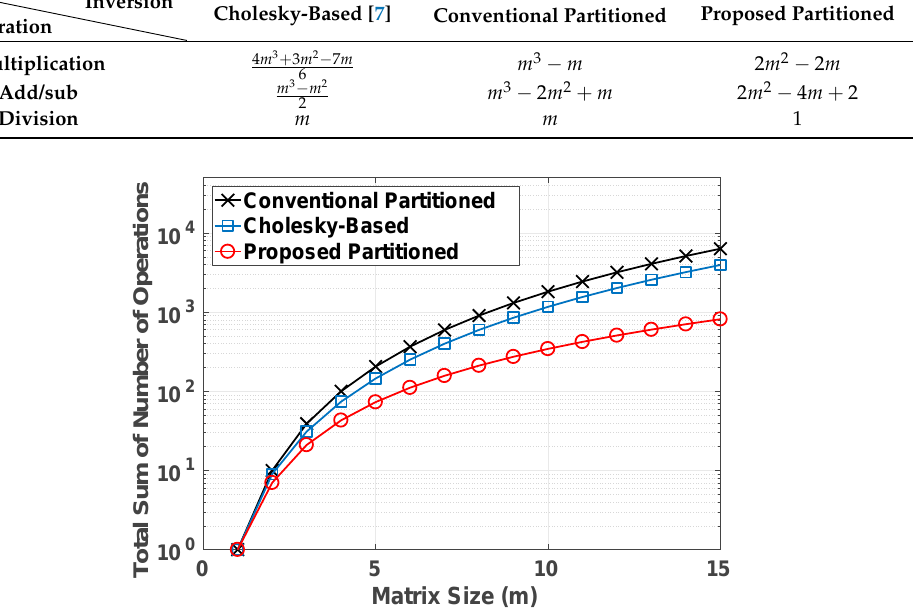
Figure 2. The total sum of number of operations for the Cholesky-based inversion, conventional partitioned inversion, and proposed partitioned inversion, depending on matrix size ( m × m ).